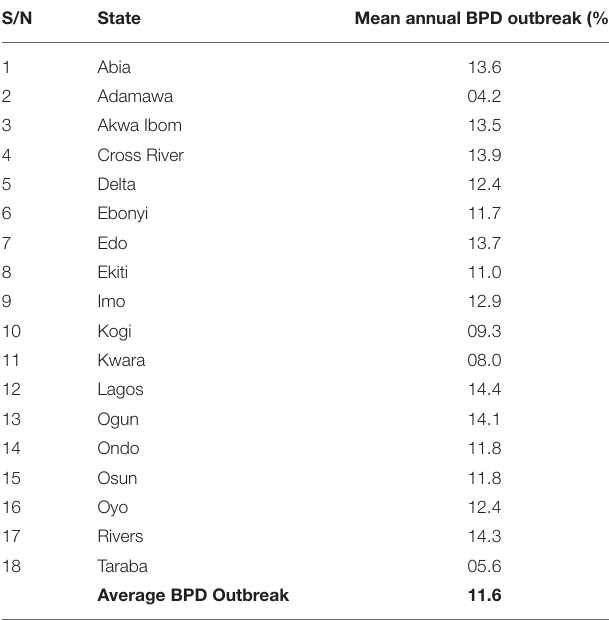
TABLE 3 | Global estimation of BPD outbreak in countries renowned for cocoa production.